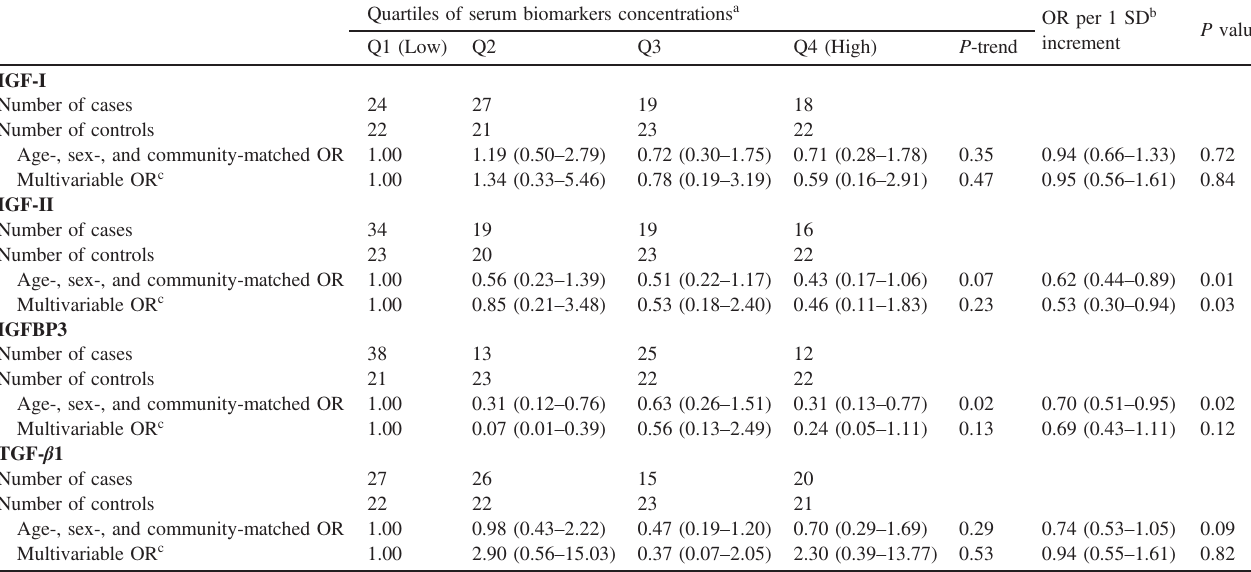
Table 2. Conditional odds ratios (ORs) and 95% con fi dence intervals (CIs) for mortality from heart failure according to quartiles and 1-SD increment of selected biomarkers ’